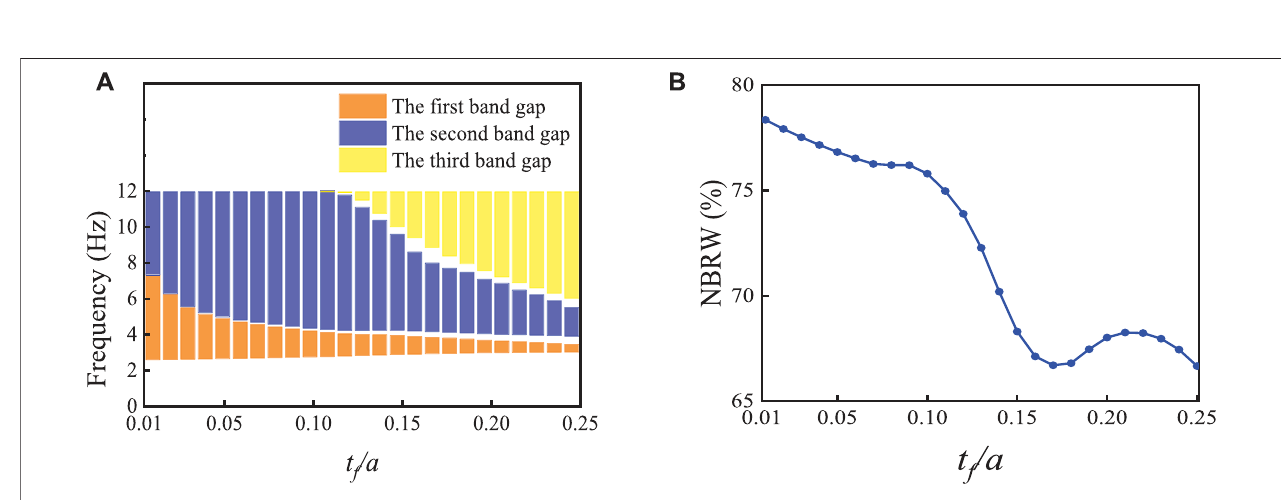
FIGURE7| Relationshipbetweenbandgapscharacteristicsandparameterratio t f /a : (A) theupperandlowerfrequencybounds ofbandgaps; (B) therelativeband width of bandgap (NRBW).